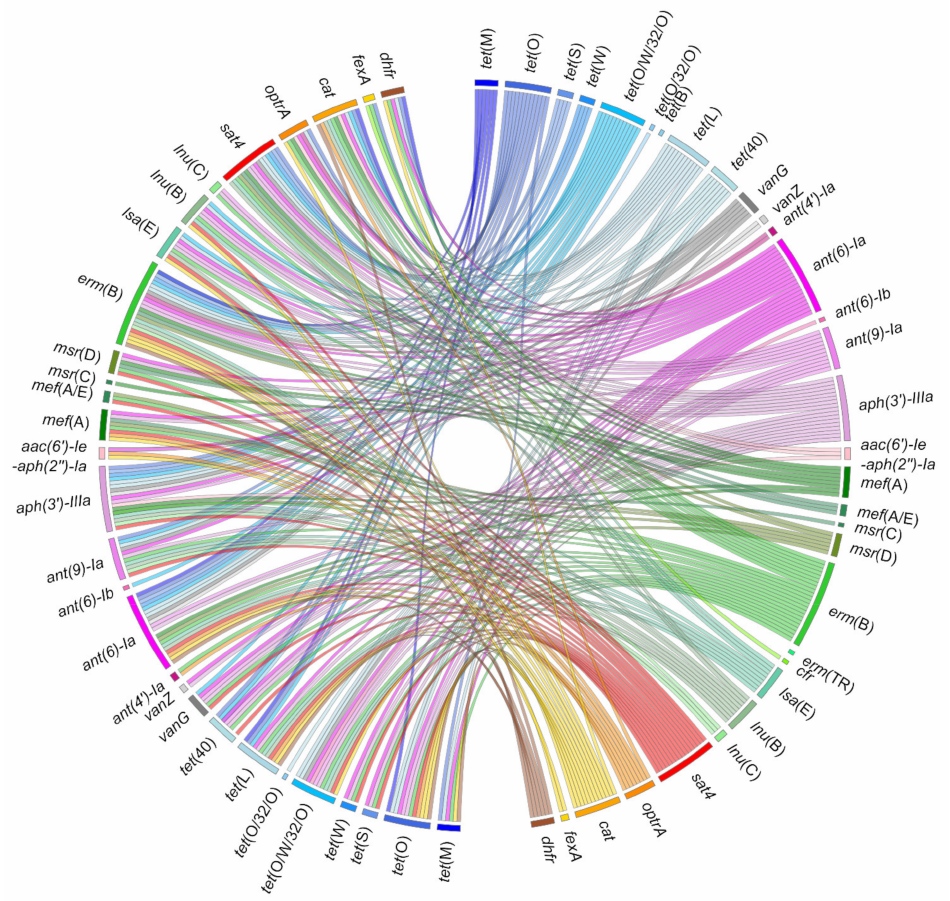
Figure 2. Co-occurrences of resistance genes described in Streptococcus suis . Ribbons indicate the co-occurrences between antibiotic resistance genes that have been reported in S. suis . The right panel includes all the genes described in S. suis . The left panel only includes those that have been described in association with other genes in the same strain of S. suis . The color code used is the same as for Figure 1. Detailed data are available as Supplementary Materials (Table